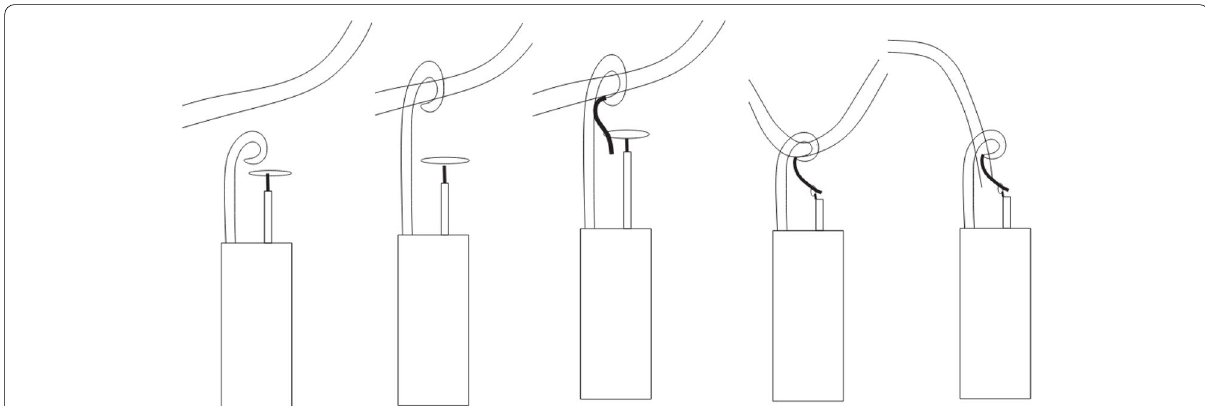
Fig. 3 Schematic diagram demonstrating the modified two-step technique that was used in this case. The pigtail catheter and snare catheter were [laced side by side ( a ), followed by hooking the pigtail catheter around the catheter fragment ( b ). A hydrophilic glidewire was then inserted through the pigtail catheter and snared ( c , d ).The pigtail catheter and snare catheter were then pulled down to create a free end ( e ) which was then